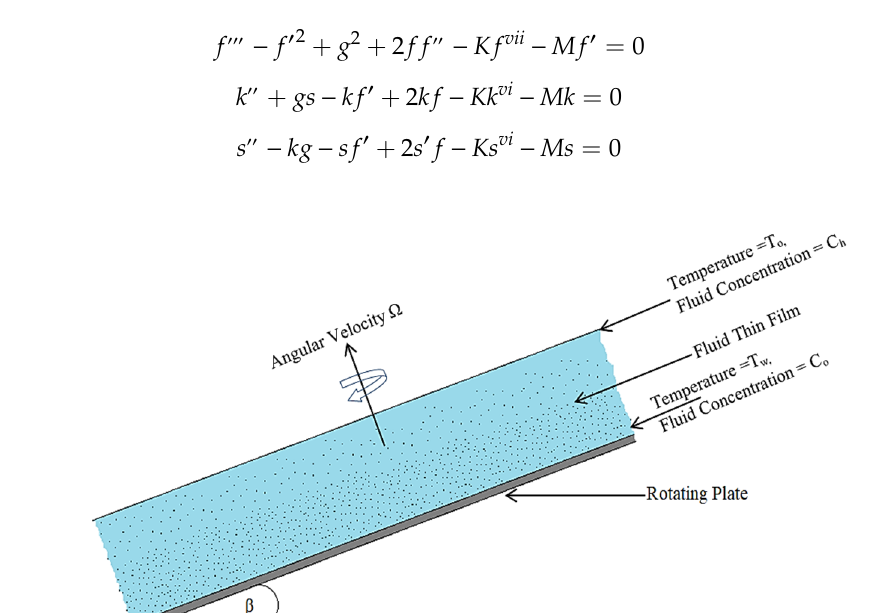
Figure 1. Geometrical description of the problem.